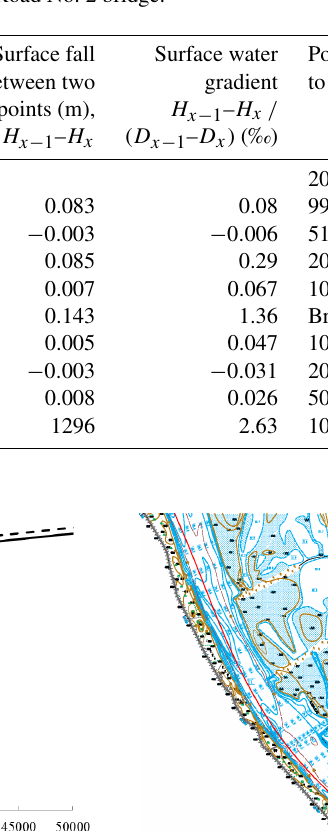
Table 3. Observed surface water fall and gradient at the Road No. 2 bridge.